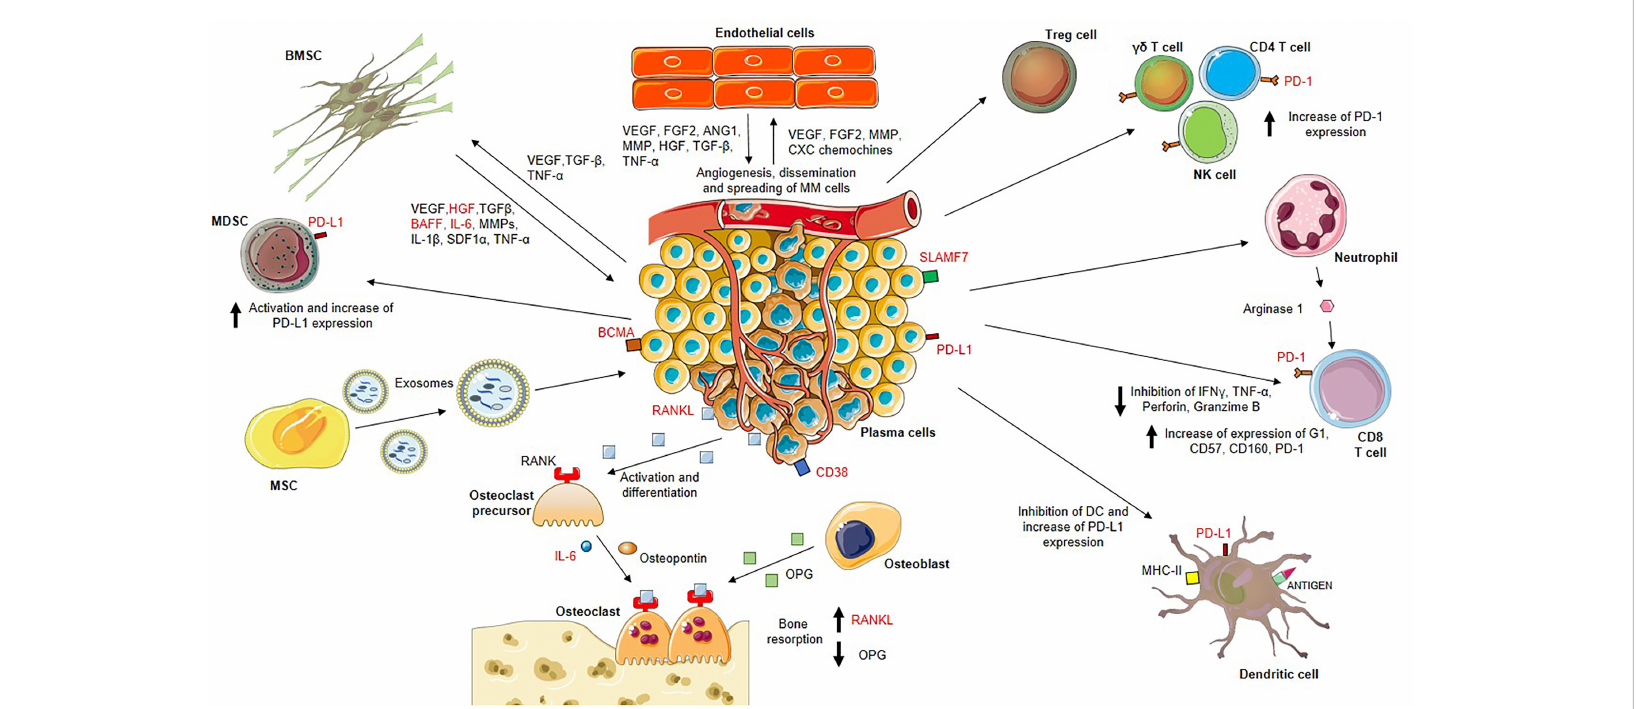
FIGURE 2 MM BM microenvironment is highly enriched in factors that sustain the proliferation of bone marrow-resident cells including myeloma plasma cells, endothelial cells and bone marrow stromal cells (BMSCs), actors of two important vicious cycles. On one hand, BMSCs release vascular endothelial growth factor (VEGF), hepatocyte growth factor (HGF), transforming growth factor- b (TGF- b ), B cell activating factor (BAFF), interleukin (IL)-6, matrix metalloproteinases (MMPs), IL-1 b , stromal cell-derived factor 1 alpha (SDF1 a ), tumor necrosis factor- a (TNF- a ) which stimulate myeloma plasma cell proliferation. On the other hand, myeloma plasma cells produce VEGF, TGF- b , TNF- a sustaining BMSC growth and activation, and endothelial cell stimulators such as VEGF, FGF2, MMP, CXC chemokines promoting neo-angiogenesis. Stimulated endothelial cells also release VEGF, FGF2, angiopoietin 1 (ANG1), MMP, HGF, TGF- b , TNF- a which ensure the nutritional support for myeloma growth. Moreover, MM BM mesenchymal stem cells (MSCs) release exosomes with higher expression of oncogenic proteins, cytokines, protein kinases and microRNAs (miRNAs) that are transferred to myeloma plasma cells resulting in MM growth. Disease progression is also promoted by the strongly immunosuppressive BM microenvironment. MM plasma cells induce activation of T regulatory (Treg) cells and myeloid-derived suppressor cells (MDSCs), and increase of the programmed cell death-1 (PD-1) expression on gamma delta ( gd ) T cells, CD4 T cells, natural killer (NK) cells and CD8 T cells. Neutrophils secrete arginase 1 involved in the dysfunction of CD8 T cells due to increased expression of PD-1, G1, CD57, CD160 and decreased secretion of IFN g , TNF- a , perforin and granzyme (B) Dendritic cells also undergo inactivation and increase levels of inhibitory markers such as programmed death-ligand 1